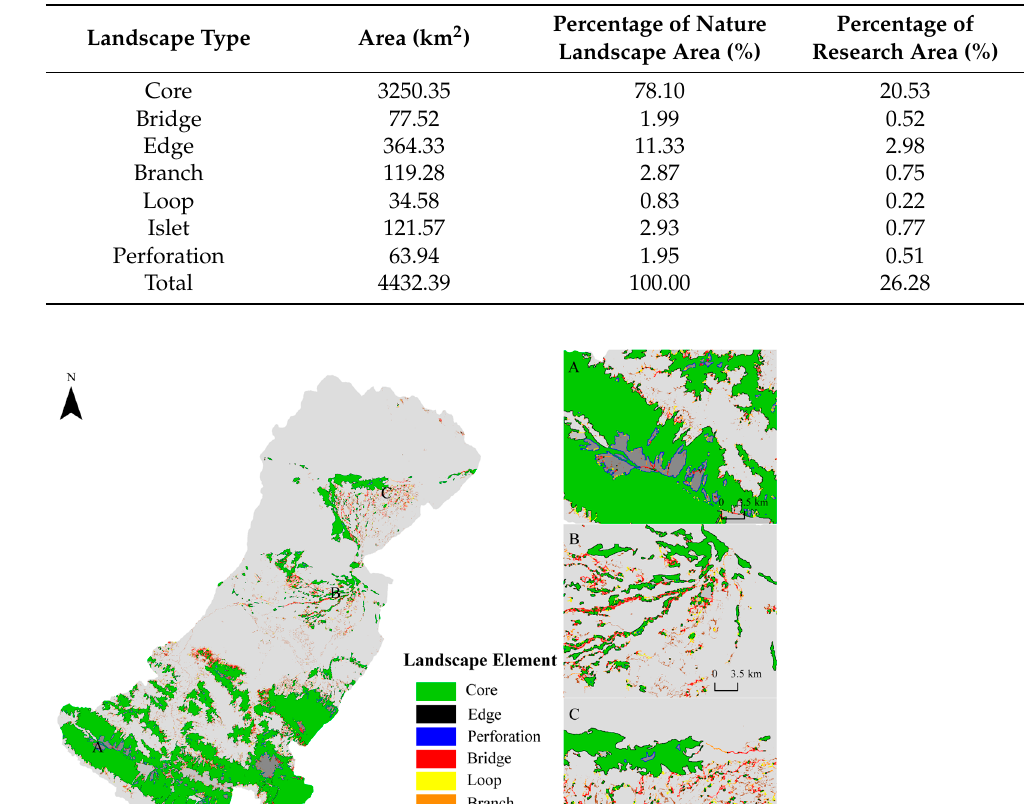
Table 3. Area and proportion of different landscape elements.